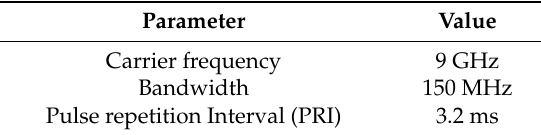
Table 2. System model parameters for data